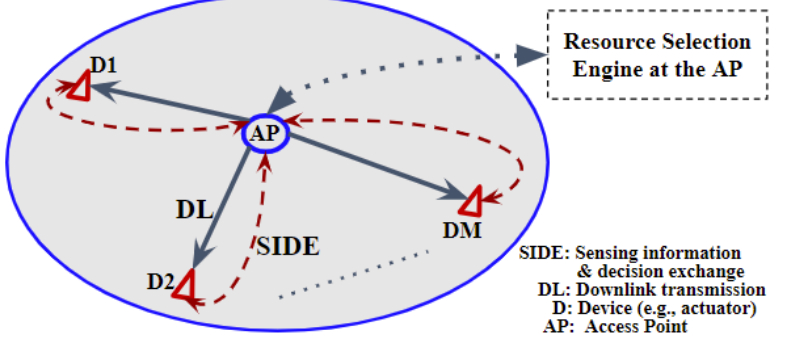
Figure 1. Illustration of DL transmission, and sensing information and resource selection decision exchange in a single